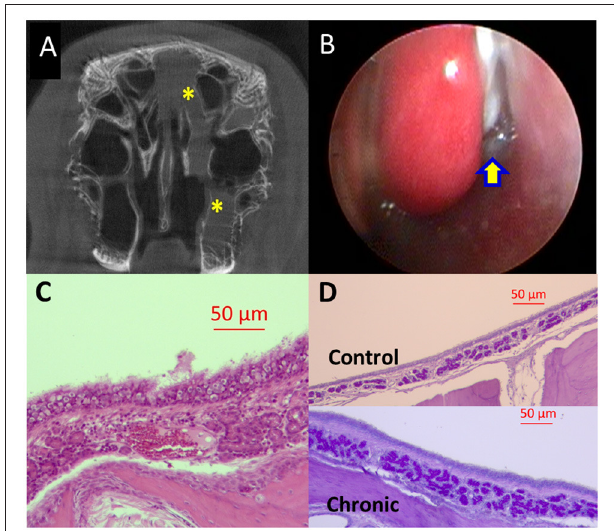
FIGURE 3 | Rabbit model of chronic sinusitis (Week 14). (A) MicroCT-partial opacification (yellow asterisk) of left sinuses. (B) Nasal endoscopic examination—purulent secretions (yellow arrow) in the middle meatus between middle turbinate and lateral nasal wall. (C) Histology—significant infiltration of plasma cells and lymphocytes with inflammatory epithelial hyperplasia and submucosal edema (scale bar upper right). (D) Histology—Periodic Acid–Schiff (PAS) staining demonstrated increased submucous glandular density with hypertrophy (lower panel) compared to control (upper panel) (scale bar upper